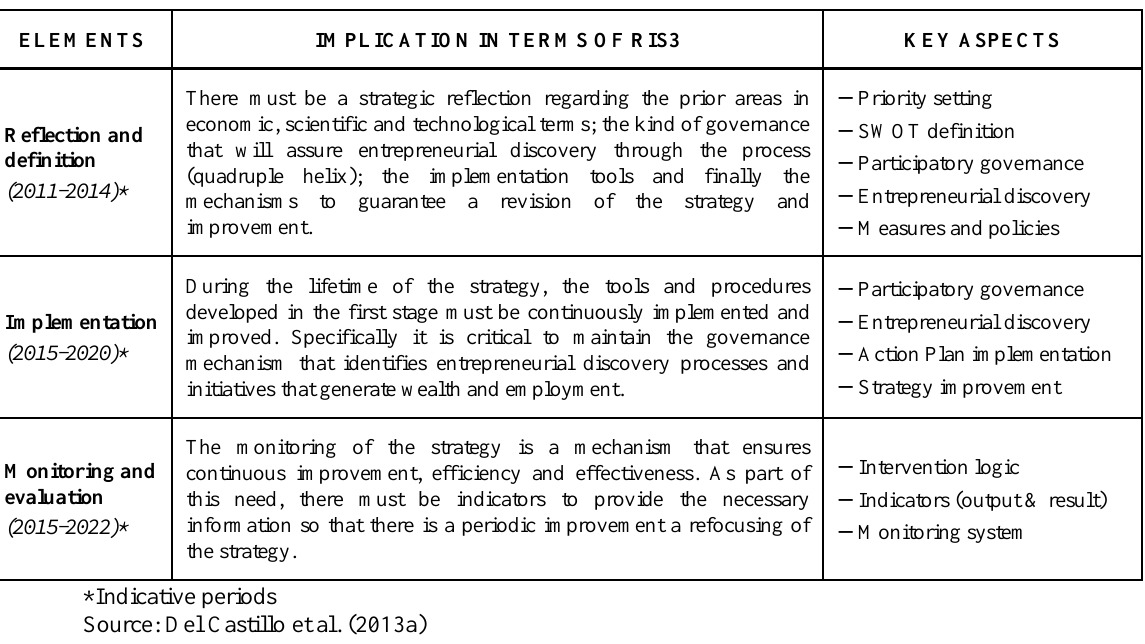
Table 1: RIS3 Elaboration Stages Regarding a Common Process of Policy